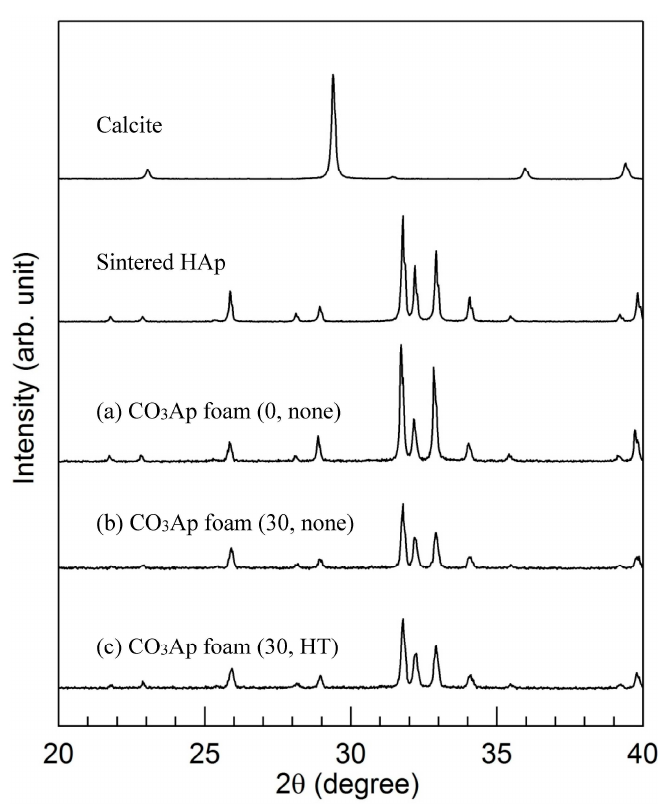
Figure 3. X-ray diffraction patterns of calcite, sintered HAp and CO 3 Ap foams: ( a ) CO 3 Ap foam (0, none); ( b ) CO 3 Ap foam (30, none); and ( c ) CO 3 Ap foam (30, HT).